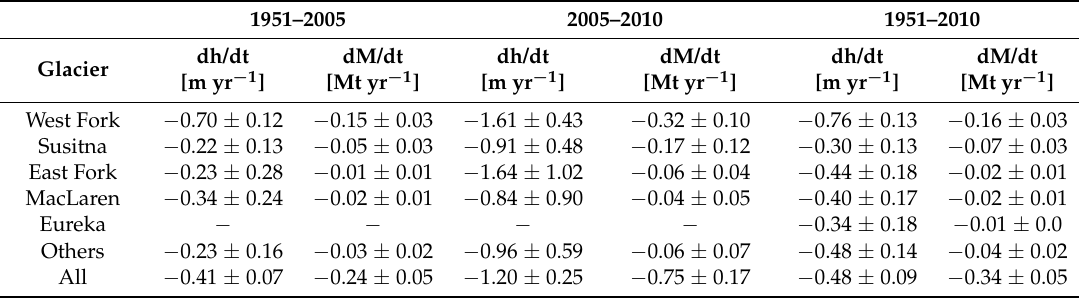
Table 3. Glacier-wide elevation (dh/dt) and mass changes (dM/dt) over two periods: 1951–2005 (NED-ASTER), 2005–2010 (ASTER-IfSAR), and 1951–2010 (NED-IfSAR). Data for Eureka Glacier (EG) is missing for the periods 1951–2005 and 2005–2010 due to the lack of ASTER DEM coverage. dM is given in megatons. Note that dh values refer to ice